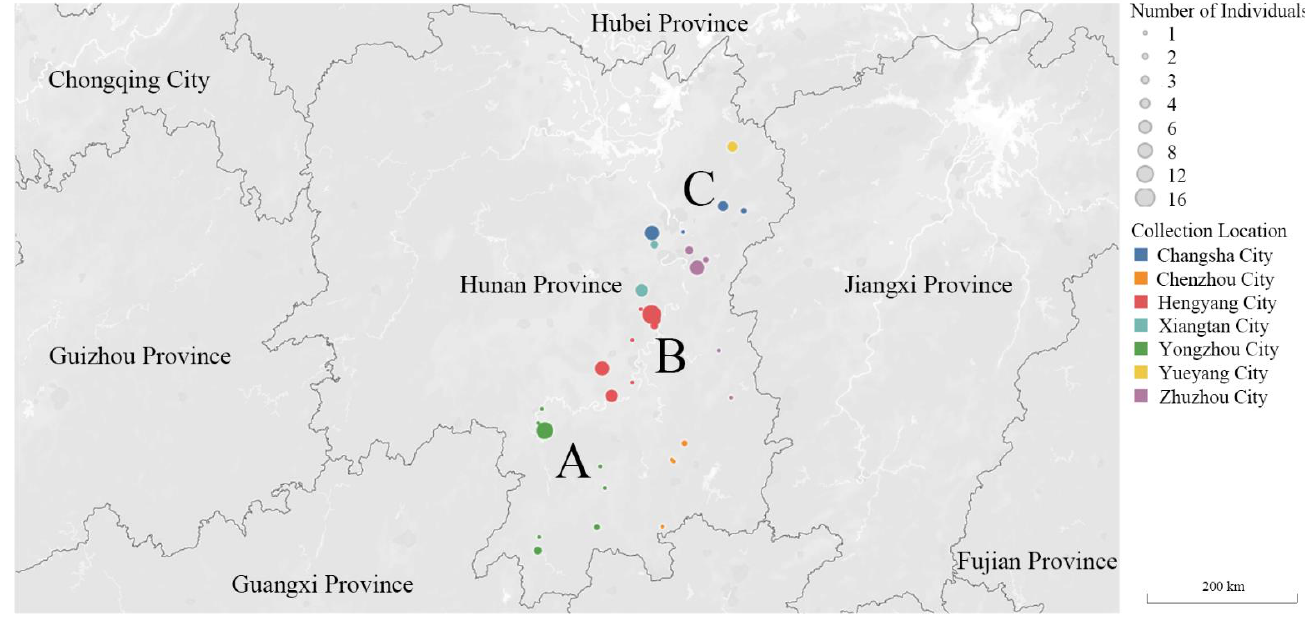
Figure 1. Sampling locations (39) in Hunan Province. Region A represent the southern part of Hunan Province (Yongzhou and Chenzhou City); Region B represents the central part of Hunan Province (Hengyang, Zhuzhou, and Xiangtan City); Region C represents the northern part of Hunan Province (Changsha and Yueyang City); Region D (not shown) represents Shanghai City.